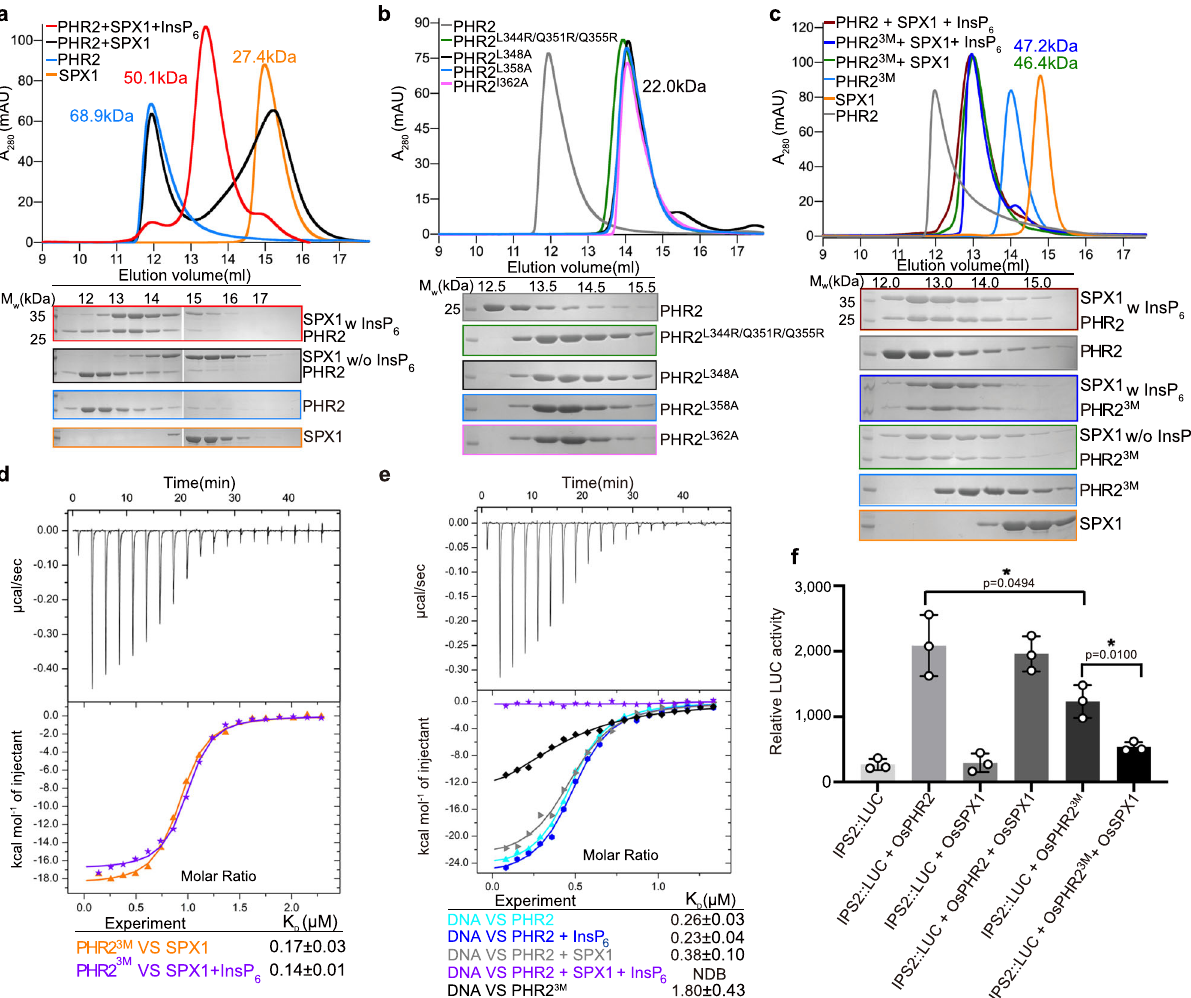
Fig. 1 Monomeric SPX1-PHR2 complex triggered by InsP 6 was determinant for PHR2-DNA binding inhibition. a SPX1 1 – 259 -PHR2 230 – 426 complex formation was induced by InsP 6 , as identi fi ed by gel fi ltration assay. (Upper) Gel fi ltration pro fi les of SPX1 1 – 259 , PHR2 230 – 426 , SPX1 1 – 259 and PHR2 230 – 426 in the presence or absence of InsP 6 were color-coded. (Lower) Coomassie-blue stained SDS-PAGE gels of peak fractions. The molecular weights were labeled based on the SEC-MALS results. Experiments were independently repeated three times with similar results. Uncropped gel images are available as source data. b Mutations of PHR2 230 – 426 disassembled the PHR2 230 – 426 dimer into monomer. The molecular weights were measured by SEC-MALS. Experiments were independently repeated three times with similar results. Uncropped gel images are available as source data. c Monomeric mutant of PHR2 230 – 426 L348A/L358A/I362A (PHR2 3M ) could interact with SPX1 1 – 259 in absence of InsP 6 . The molecular weights were measured by SEC-MALS. Experiments were independently repeated three times with similar results. Uncropped gel images are available as source data. d Binding af fi nity of PHR2 3M with SPX1 1 – 259 in the presence (purple) or absence of InsP 6 (orange) were detected by ITC. e Effects of SPX1, InsP 6 , and PHR2 3M on PHR2-DNA(P1BS) binding af fi nity as detected by ITC. ITC curves for the titration of DNA (P1BS) with PHR2 230 – 426 (cyan); PHR2 230 – 426 and InsP 6 (blue); PHR2 230 – 426 and